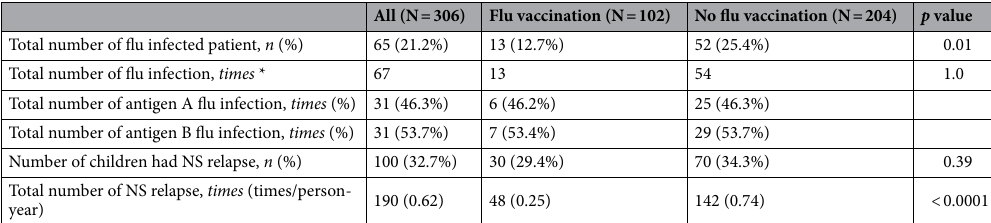
Table 2. Flu infections and nephrotic syndrome relapses. NS; nephrotic syndrome, Flu; influenza virus, * Of 65 children with flu infection, 67 times diagnosed using rapid antigen detection tests with nasopharyngeal swab samples were